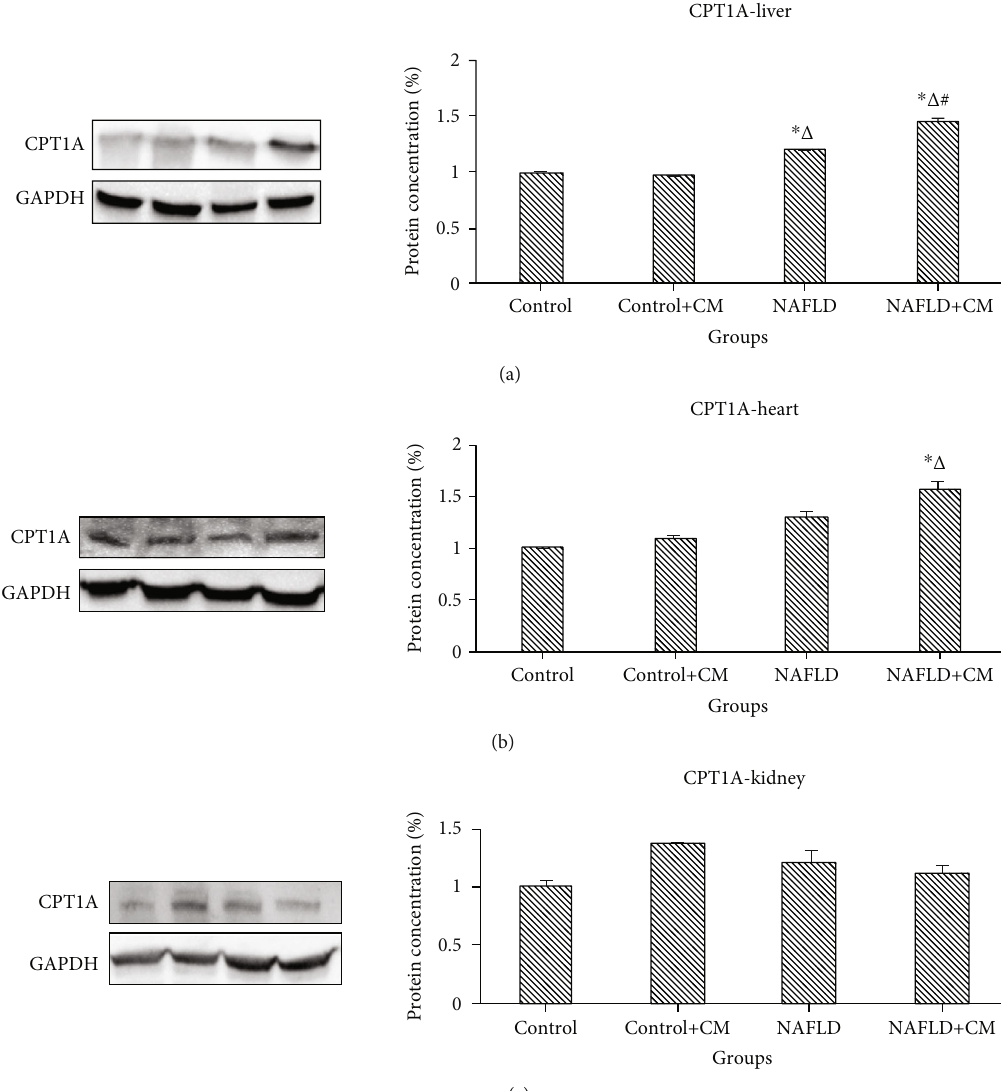
Figure 3: CPT1A protein expression in the liver (a), heart (b), and kidney (c) tissues of the control, camel milk (CM) treated control (control+CM), nonalcoholic fatty liver disease (NAFLD), and CM-treated NAFLD (NAFLD+CM) animals. The protein bands were quanti fi ed relative to GAPDH. ∗ p < 0 : 05 versus the control group, Δ p < 0 : 05 versus the control+CM group, and # p < 0 : 05 versus the NAFLD